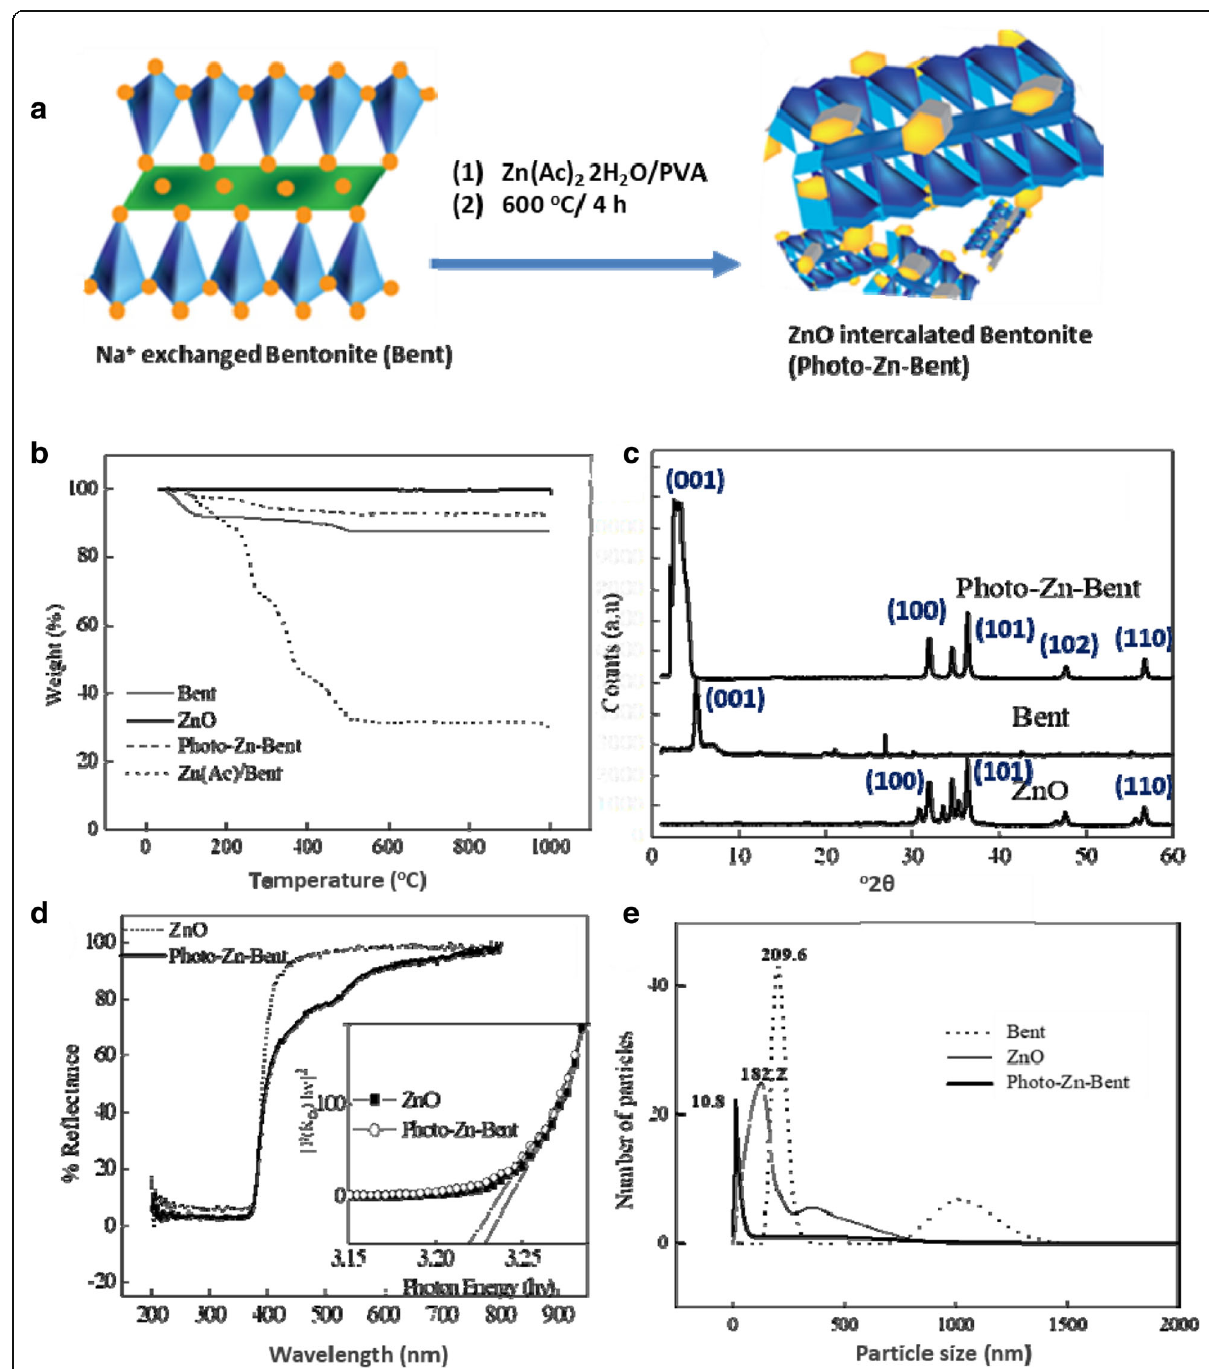
Fig. 1 ( a ) Schematic representation of synthesis of Photo-Zn-Bent, ( b ) TGA pattern of Bent, Zn(Ac)/Bent, ZnO and Photo-Zn-Bent, ( c ) XRD pattern of ZnO, Bent and Photo-Zn-Bent, ( d ) DRS spectra of ZnO and Photo-Zn-Bent. Inset of ( d ) shows Kubelka-Munk transformed reflectance spectra of ZnO and Photo-Zn-Bent. ( e ) Photon correlation spectra of Bent, ZnO and Photo-Zn-Bent showing particle size